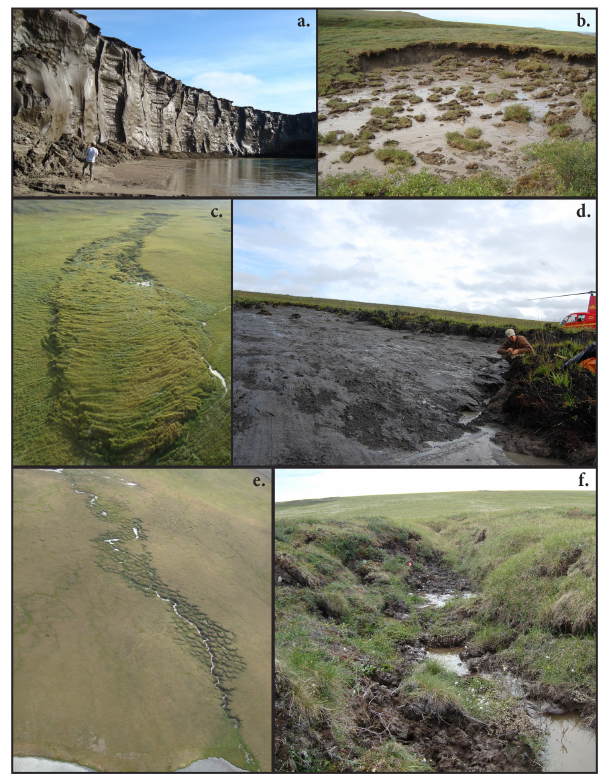
Figure 1. The three most common thermokarst morphologies in up- land tundra: retrogressive thaw slumps (panels a , b ), active-layer detachment slides ( c , d ), and thermo-erosion gullies ( e , f ). Photo in panel (c) by A. W.